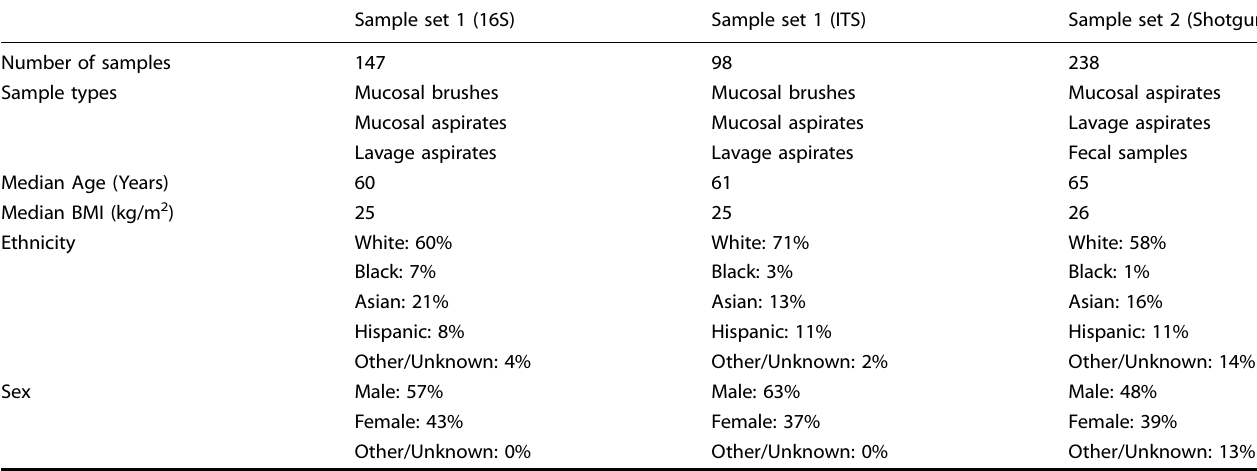
Table 1. Study cohort